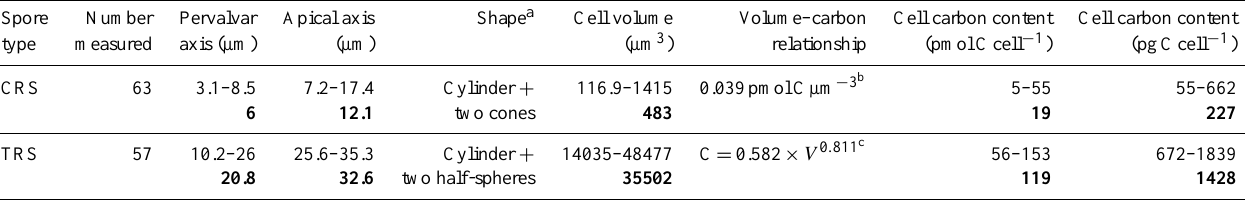
Table 2. Chaetoceros resting spores (CRS) and Thalassiosira antarctica resting spores (TRS) measurement and biomass data from station A3 sediment trap. The range and the mean value (bold) are reported for each